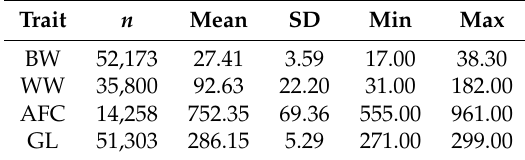
Table 1. Descriptive statistics of the birth weight (BW), weaning weight (WW), age at first calving (AFC), and gestation length (GL) of Hanwoo cattle. Trait n Mean SD Min Max BW 52,173 27.41 3.59 17.00 38.30 WW 35,800 92.63 22.20 31.00 182.00 AFC 14,258 752.35 69.36 555.00 GL 51,303